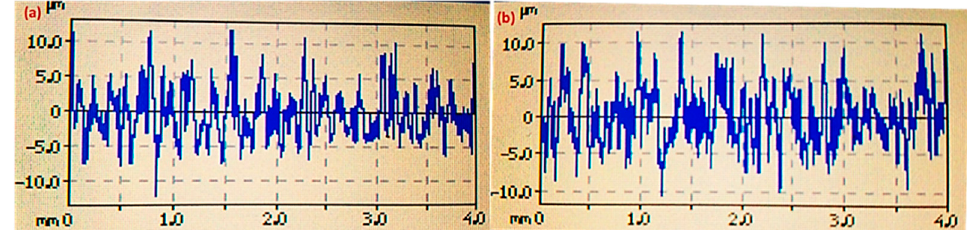
Figure 7. Surface roughness profiles of the machined surface at ( a ) 50 and ( b ) 80 V.